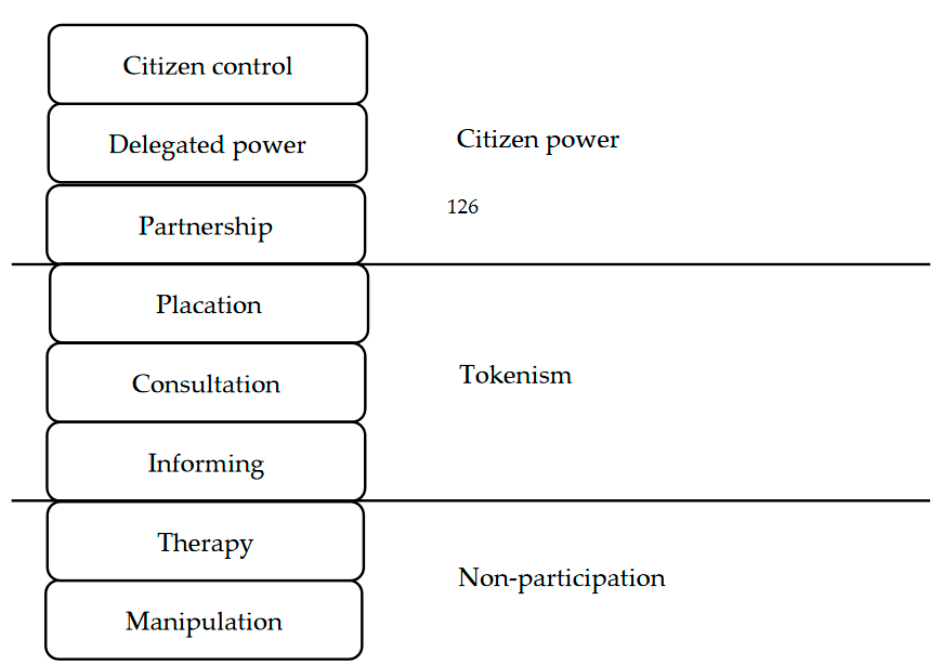
Figure 2. Ladder of Citizen Participation (Gaber 2020).